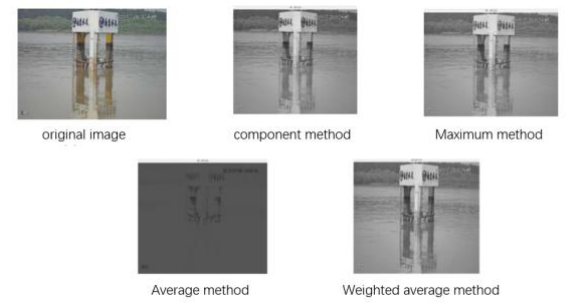
Figure 5 . Comparison of grayscale effects.